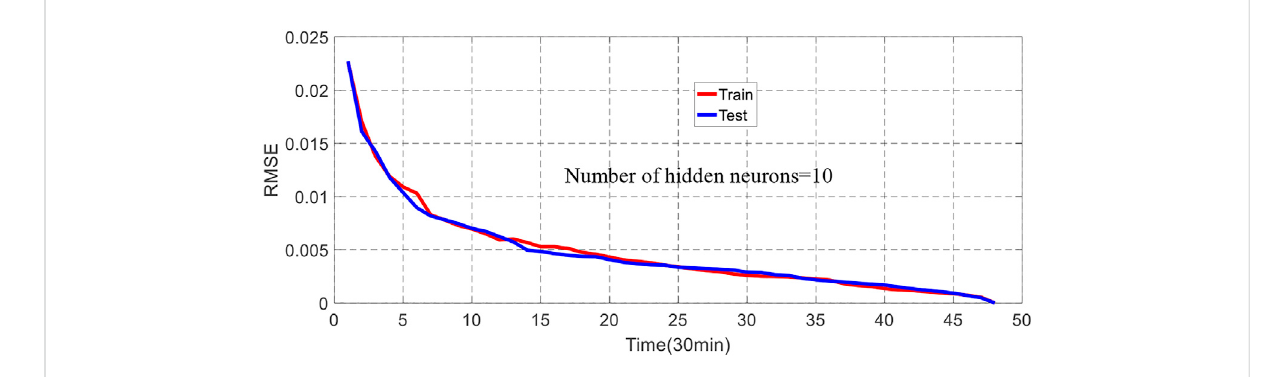
FIGURE 11 RMSE for load demand forecasting using 10 hidden neurons (1 day).